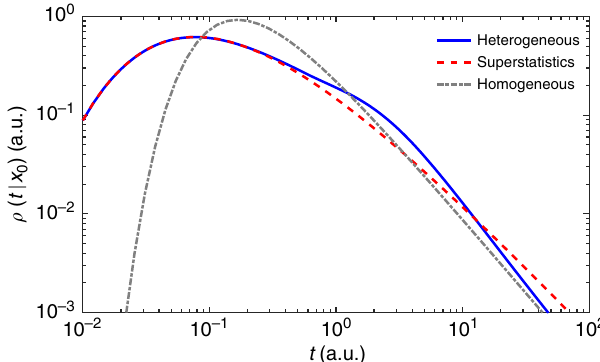
Fig. 5 First-passage times on the half-line. Probability density function fi rst-passage time to the absorbing endpoint 0 of the half-line ρ ( t | x 0 ) of the (0, ∞ ), with (cid:1) D = 1, σ = 1, x 0 = 1, and τ = 2 (here arbitrary units are used). The exact solution (55) (solid line) is compared to the superstatistical approximation (62) (dashed line) and the probability density function (56) for homogeneous diffusion (dash-dotted